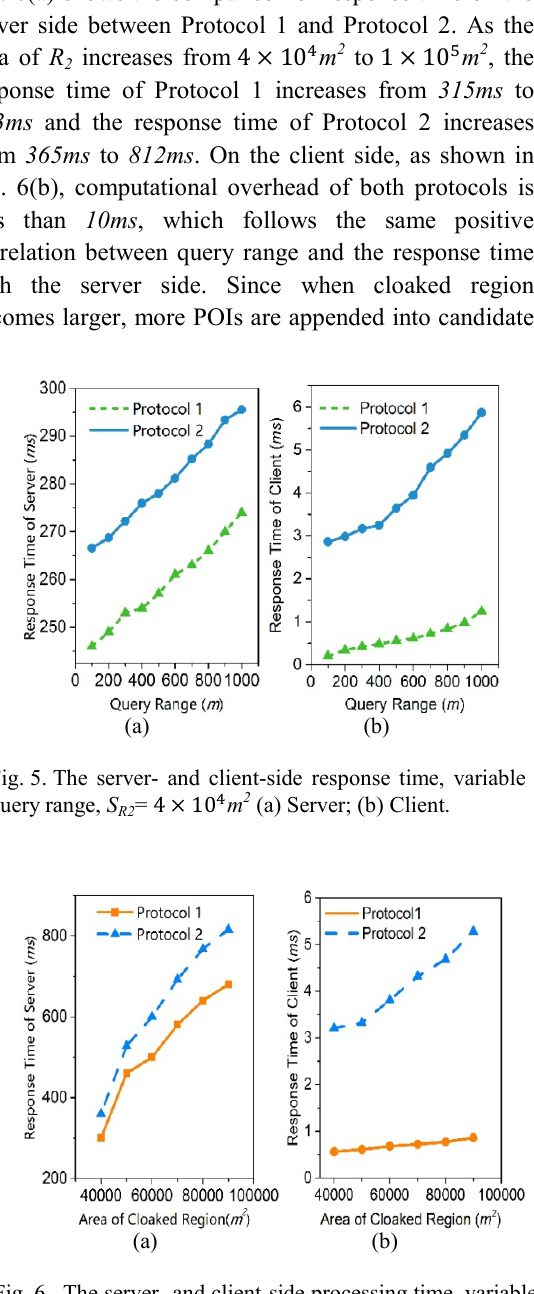
Fig. 6. The server- and client-side processing time, variable cloaking region, r = 1000. (a) Server; (b)